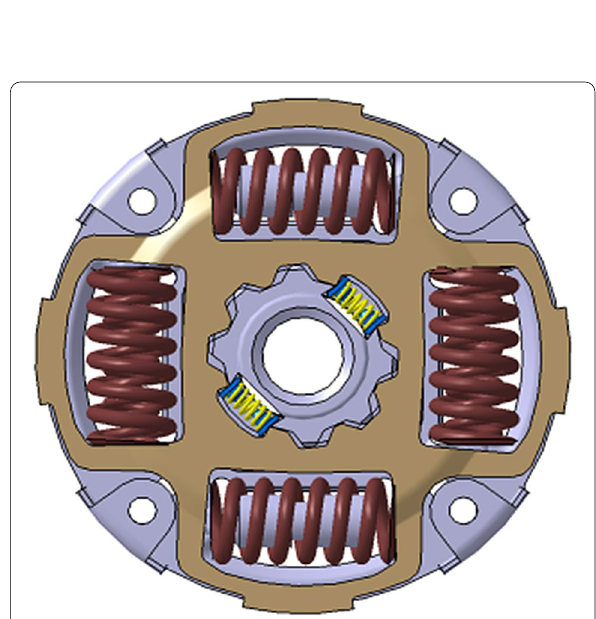
Figure 6 Schematic illustration of internal structure of wide-angle, low-stiffness